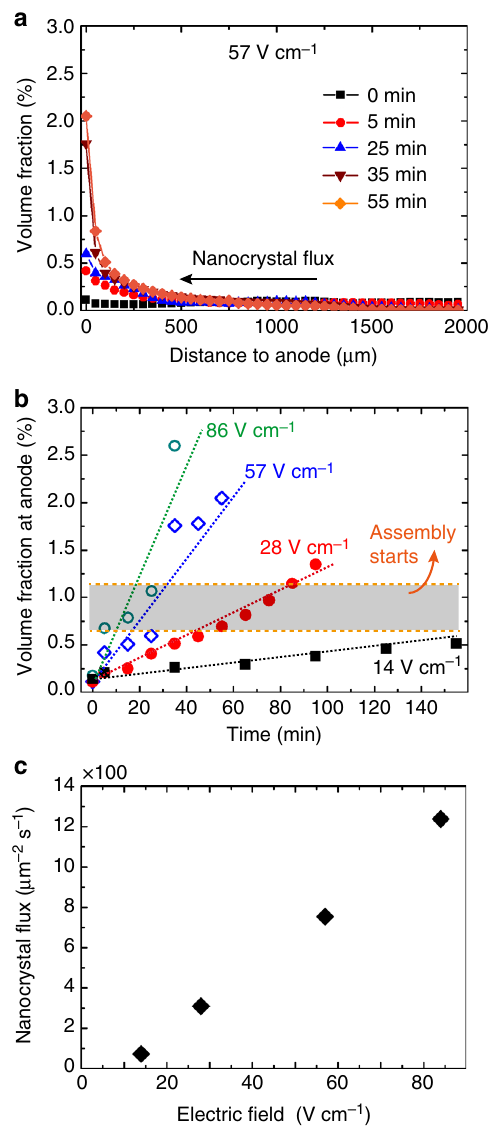
Fig. 4 In situ SAXS shows higher nanocrystal fl ux to the anode under stronger fi elds. a Plots of volume fraction of nanocrystal solution against its distance to the anode, under an applied fi eld of 57 V cm − 1 for various times. Black squares, red circles, blue triangles, brown upside down triangles, and orange diamonds are used for 0, 5, 25, 35, and 55 min, respectively. b The volume fraction of nanocrystal solution at the anode surface plotted against the time that electric fi elds have been applied for. Black squares, red solid circles, blue open diamonds, and green open circles represent fi elds of 14, 28, 57, and 86 V cm − 1 , respectively. The dotted lines are linear fi ts. c The calculated nanocrystal fl ux entering the 50 µ m thick slice of solution near the